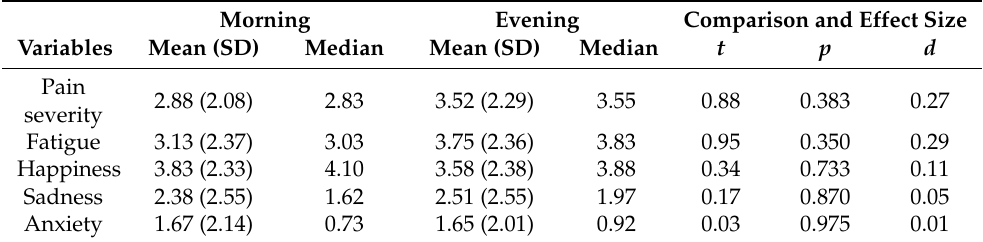
Table 1. Clinical characteristics of the sample (average scores throughout the study).